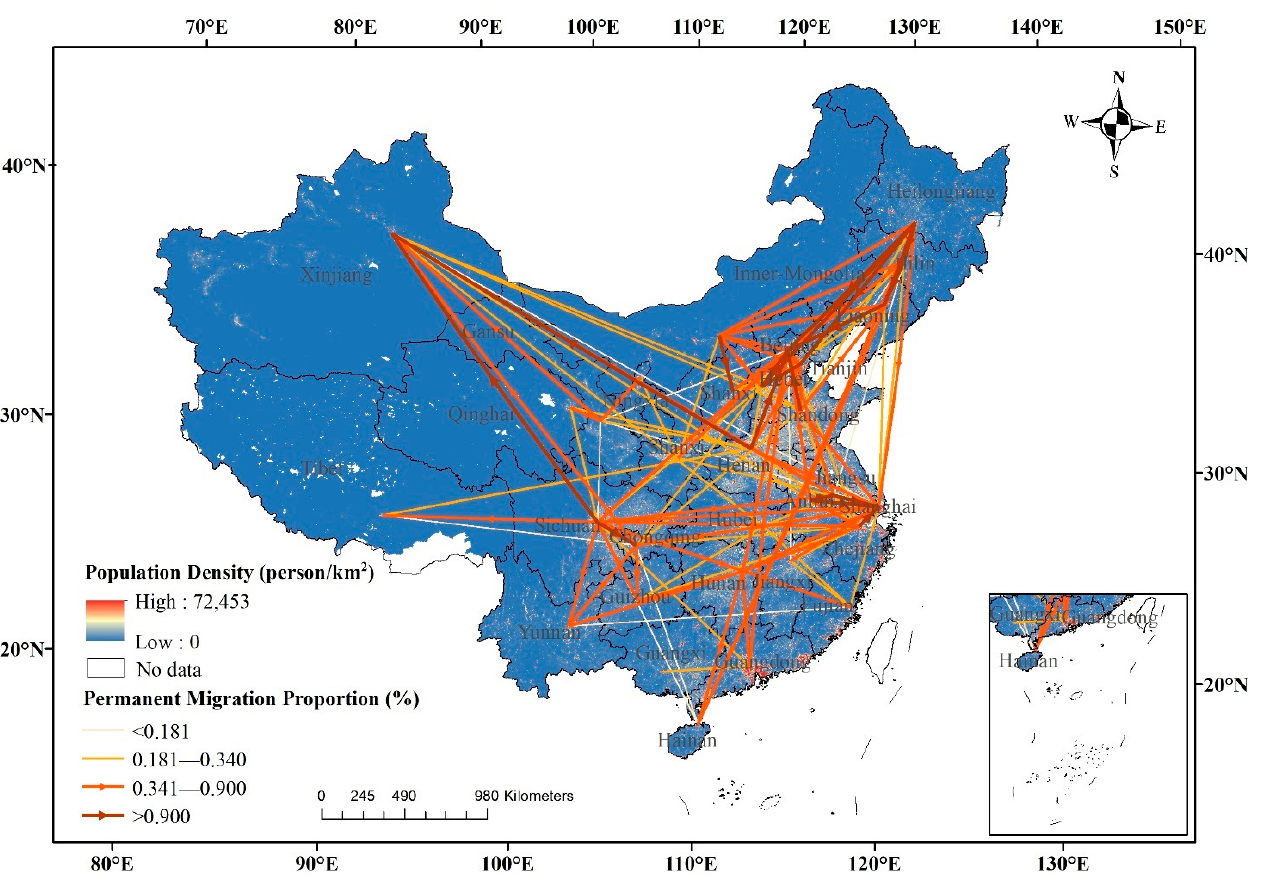
Figure 2. Migration flows of older migrants on the provincial scale in China in 2017. Note: The population density data were obtained from Resource and Environment Science and Data Center (https://www.resdc.cn/, accessed on 1 January 2021).